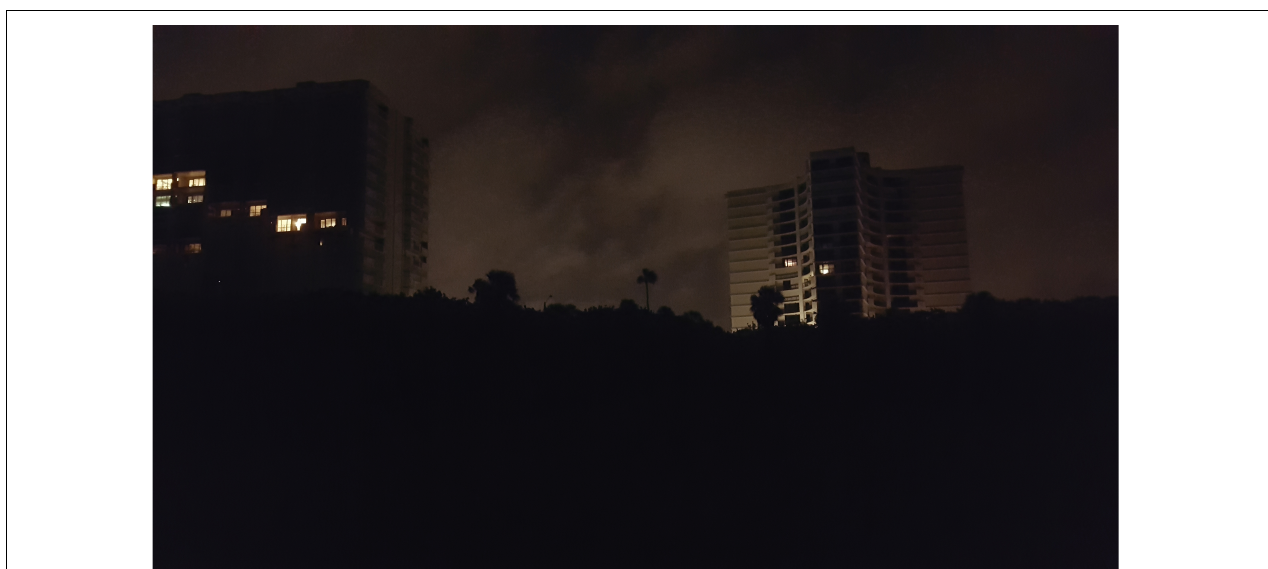
FIGURE 4 | Two condominiums in Boca Raton with sky glow and common urban lighting visible from the beach. Low clouds increase the reflection of lights from the adjacent city and sky glow. Sky glow is associated with hatchling disorientation. TABLE 3 | Causes of hatchling mortality by site. Causes of mortality Ghost crabs Ants Gulls Night heron Fox